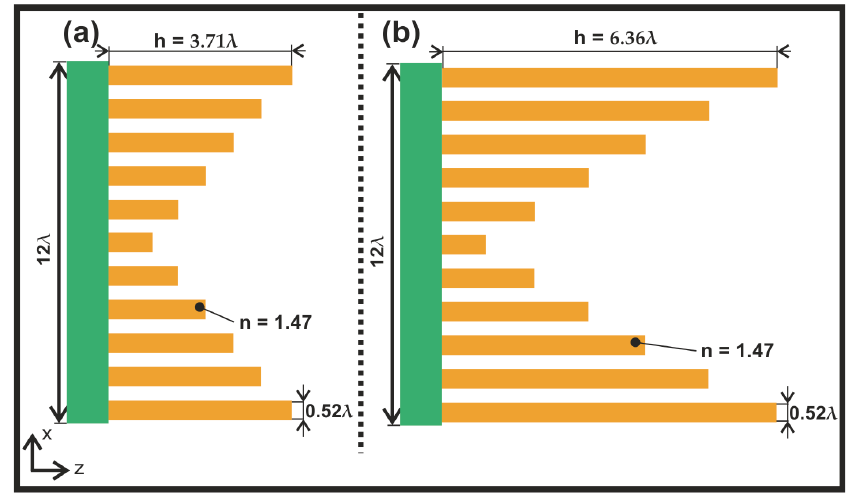
Figure 4. Cross sections of the studied 3D microstructures with a GRIN substrate in the xz plane.